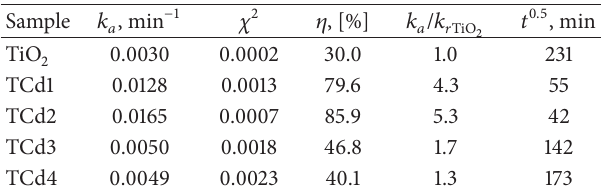
Table 5: Kinetics parameters and photocatalytic degradation effi- ciency ( 𝜂 ) of MB achieved over the different CdS/TiO 2